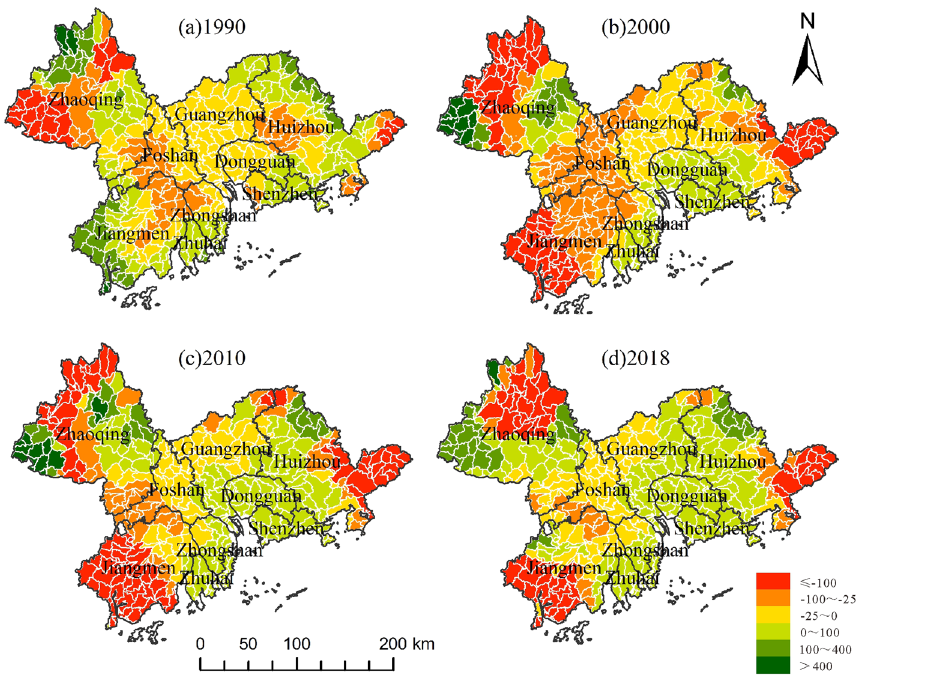
Figure 8. Spatial pattern of correlation coefficient between POP and habitat